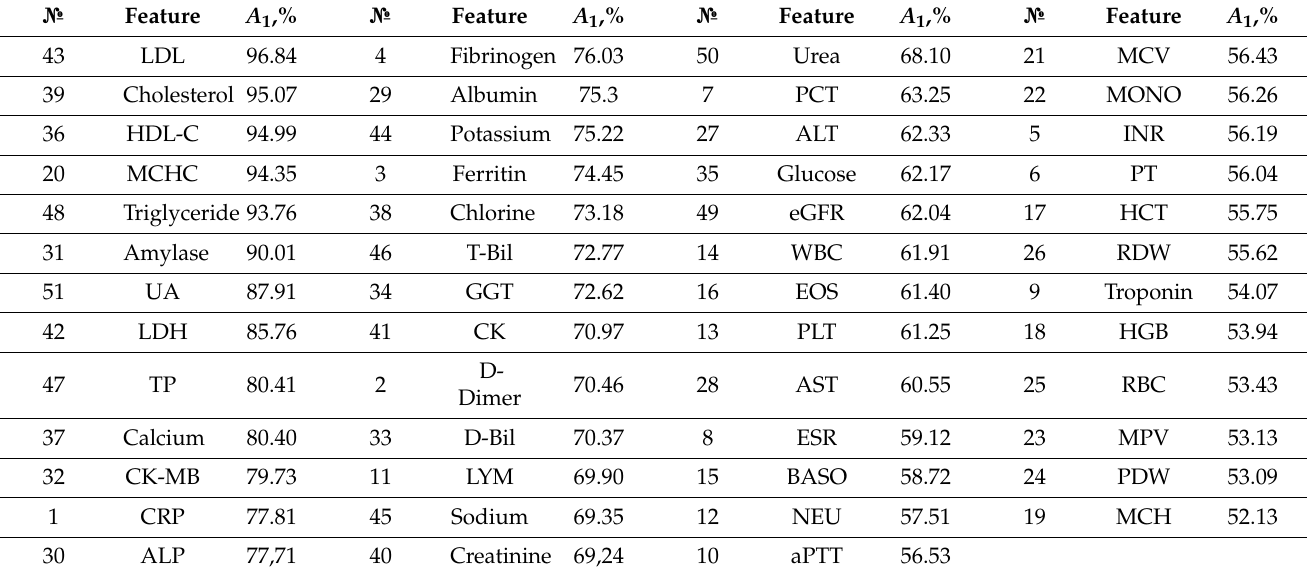
Table 6. Classification efficiency of SARS-CoV-2-RBV1 datasets using the single feature for the Histogram-based Gradient Boosting